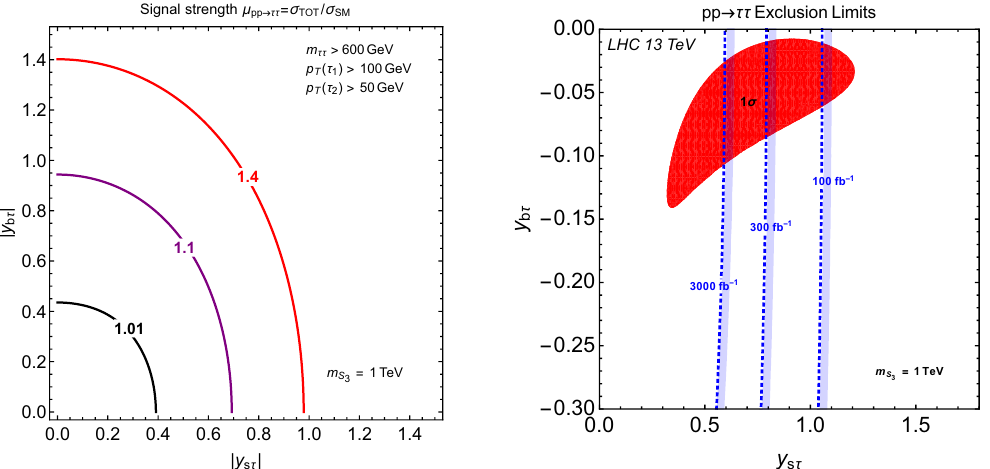
Figure 6 . (Left panel) Contours of constant signal strength (cid:22) pp (cid:28)(cid:28) for di(cid:11)erent deviations from ! the SM prediction at m S = 1 TeV. (Right panel) 95% C.L. limits for LHC luminosities of 100, 3 300, and, 3000 fb (cid:0) 1 (dotted blue contours) from recasting high-mass (cid:28)(cid:28) searches by ATLAS [83] for m S = 1 TeV. The red region corresponds to the 1 (cid:27) low-energy (cid:12)t. 3 s (cid:22) s ! (cid:28) + (cid:28) (cid:0) , s (cid:22) b ((cid:22) sb ) ! (cid:28) + (cid:28) (cid:0) , b (cid:22) b ! (cid:28) + (cid:28) (cid:0) and c (cid:22) c ( u (cid:22) u ) ( u (cid:22) c ) ! (cid:28) + (cid:28) (cid:0) respectively. These